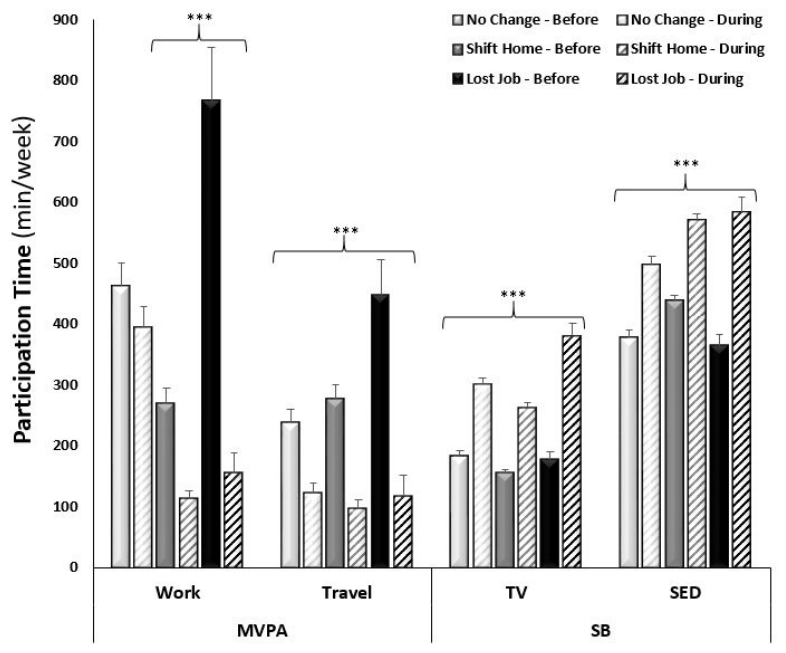
Figure 3. Average weekly self-reported time (minutes) spent in moderate-to-vigorous physical activity (MVPA) related to work and travel and time spent in sedentary behaviors (watching TV and sitting) separated by employment status or environment change by time point. Significant difference within employment status and environment change by time point (*** adj. p < 0.0001).